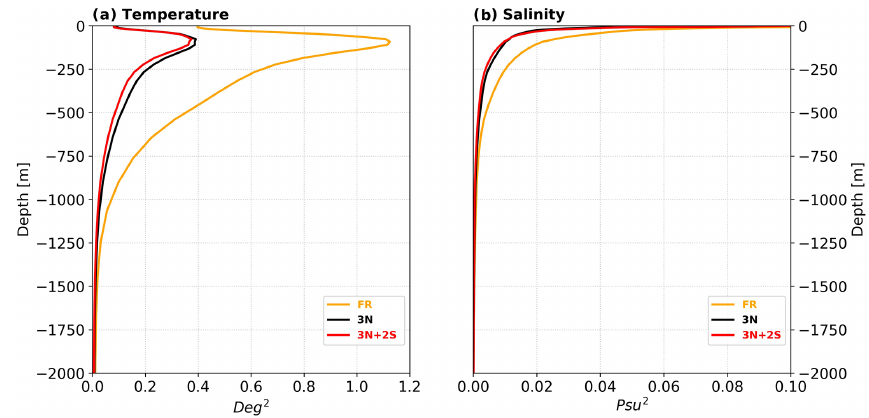
Figure 13. Global averaged error variance: (a) temperature (in Deg 2 ) and (b) salinity (Psu 2 ) over the period of March to December 2015. The results were obtained by comparing the zonal and meridional velocities of OSSEs with the NR; FR (orange lines), 3N (black lines) and 3N + 2S (red lines).